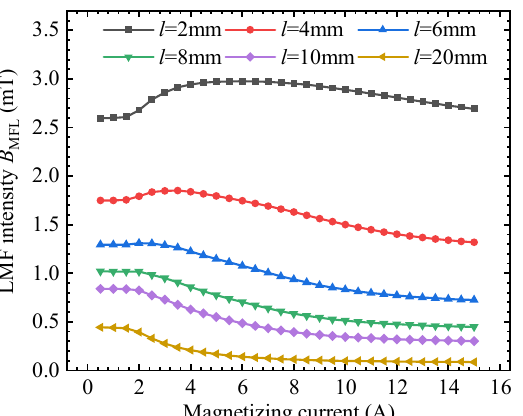
Figure 6. The relationship between the defect LMF intensity and the magnetizing current with coils of different lengths.